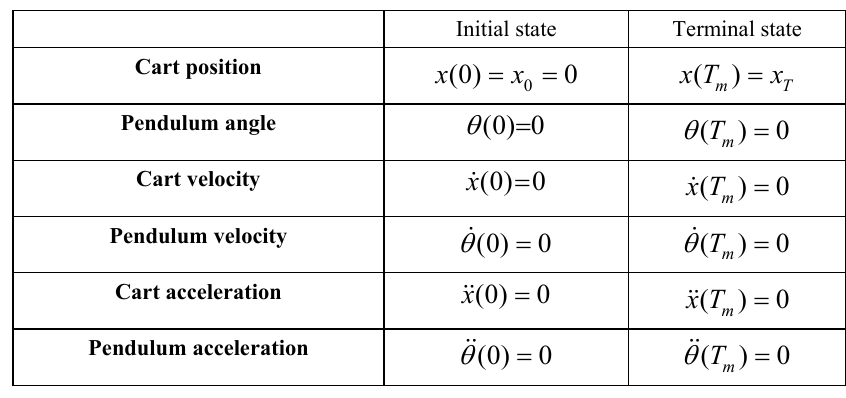
Table 2. Initial states and terminal states in